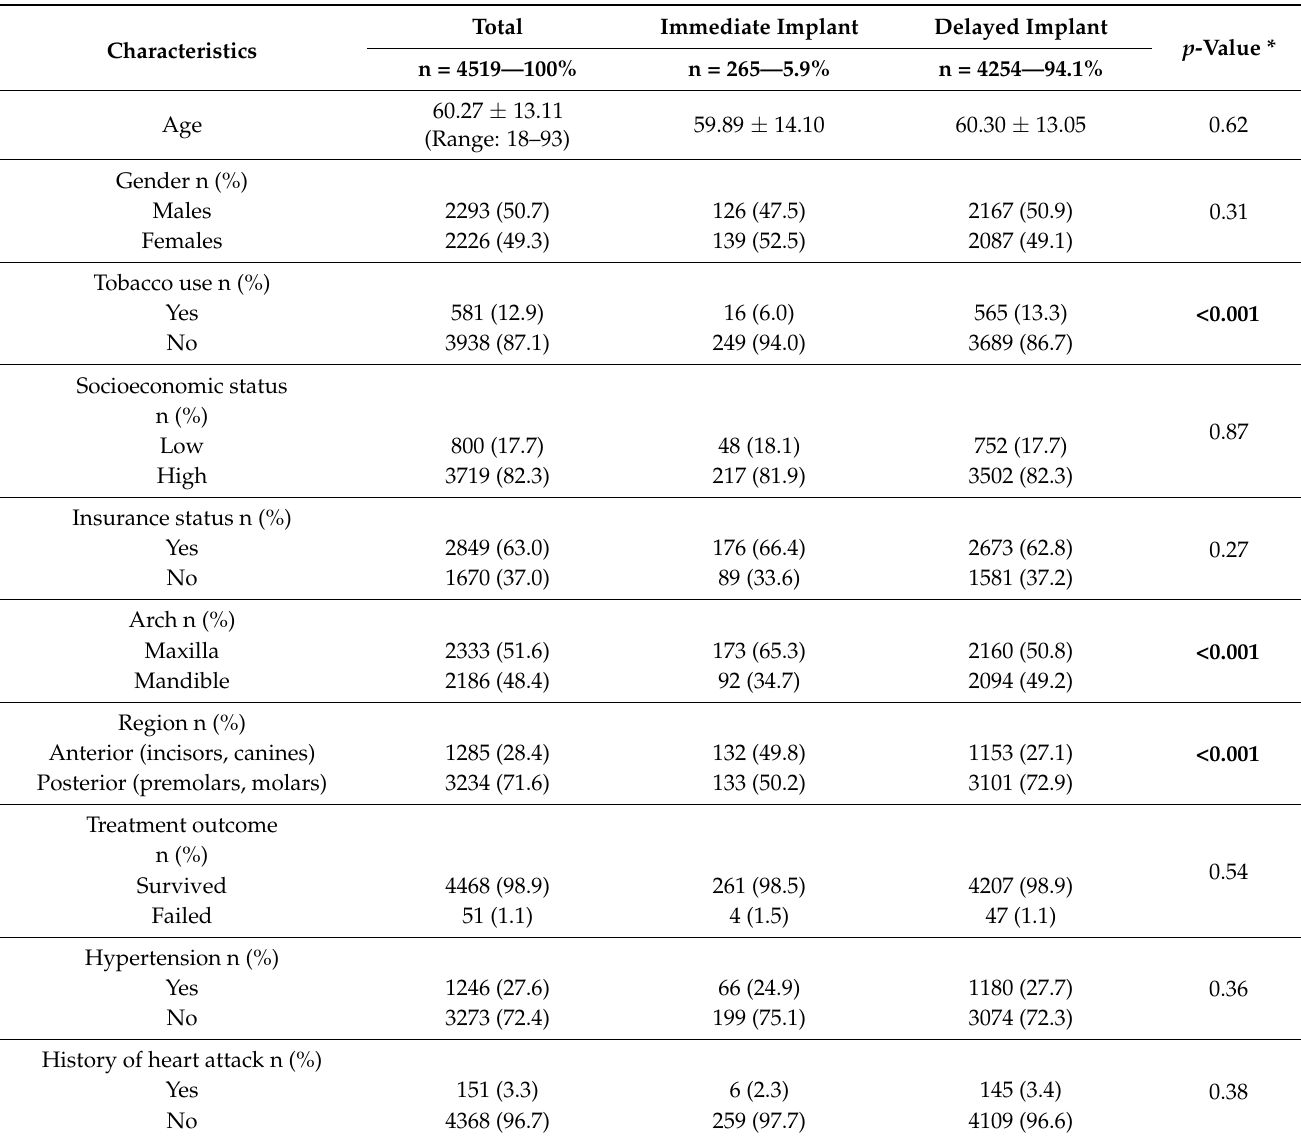
Table 1. Demographic, site and patient characteristics of the immediate and delayed implant treat- ment groups as well as of the total